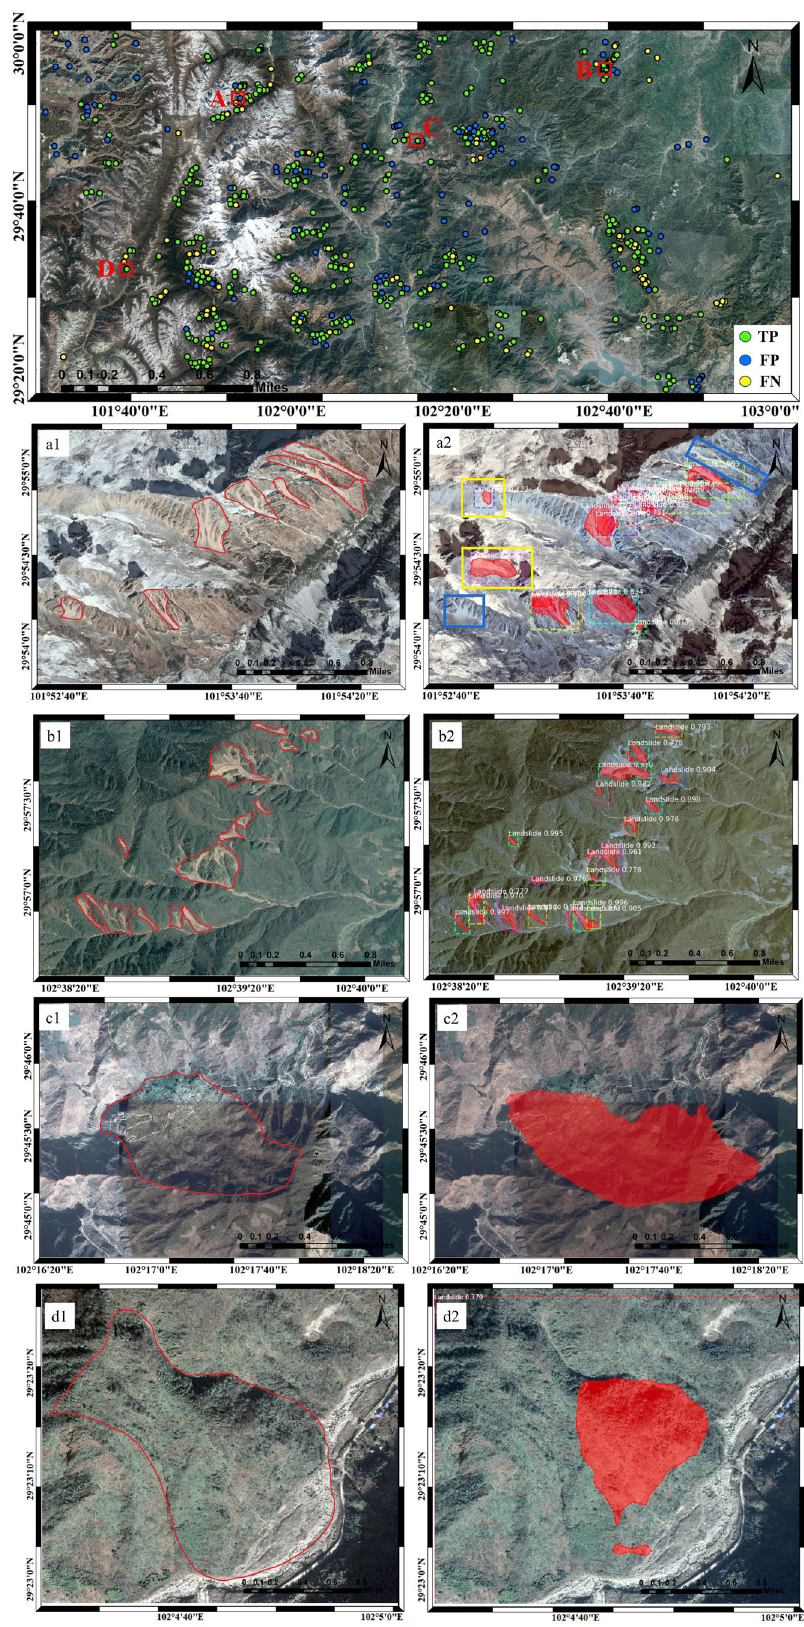
Figure 12. The verification area landslides detection results. ( a1 , b1 , c1 , d1 ) represent the original image, ( a2 , b2 , c2 , d2 ) are the results of our model.